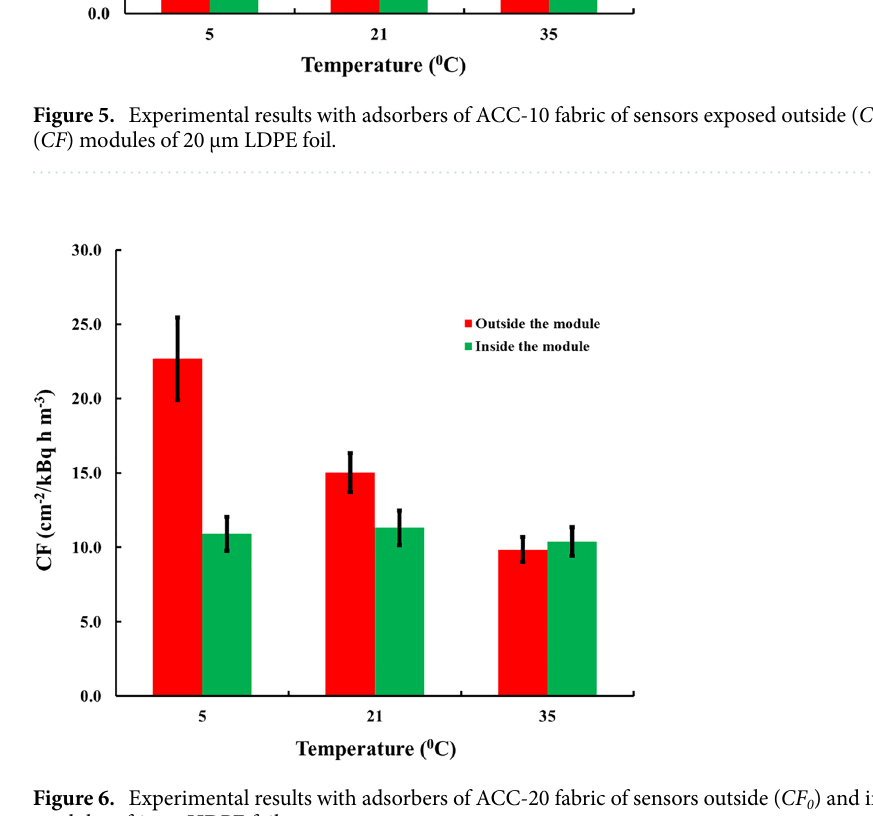
Figure 6. Experimental results with adsorbers of ACC-20 fabric of sensors outside ( CF 0 ) and inside ( CF ) modules of 9 µm HDPE